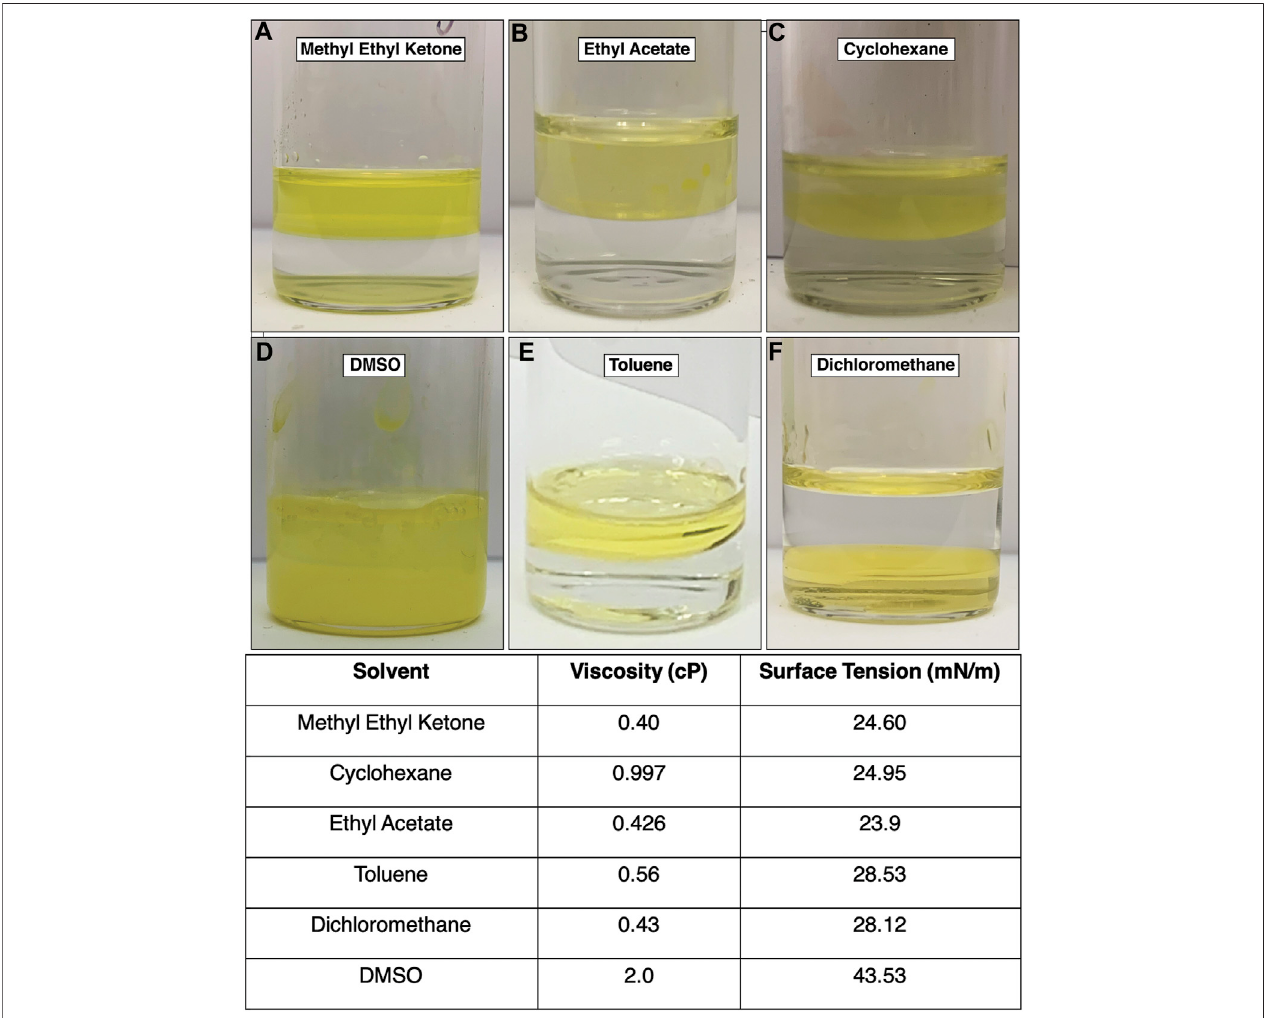
FIGURE 2 | (A) – (F) Images of each interface using different organic solvents. The dichloromethane interface inverted (F) and the DMSO interface broke, with productsinkingtothebottomofthevial.Thetolueneinterfaceisalsoimagedasaframeofreference.Table1.Eachsolventislistedwithitsliteratureviscosityincentipoise (cP), and its literature air-liquid surface tension in millinewtons-per-meter (mN/m).